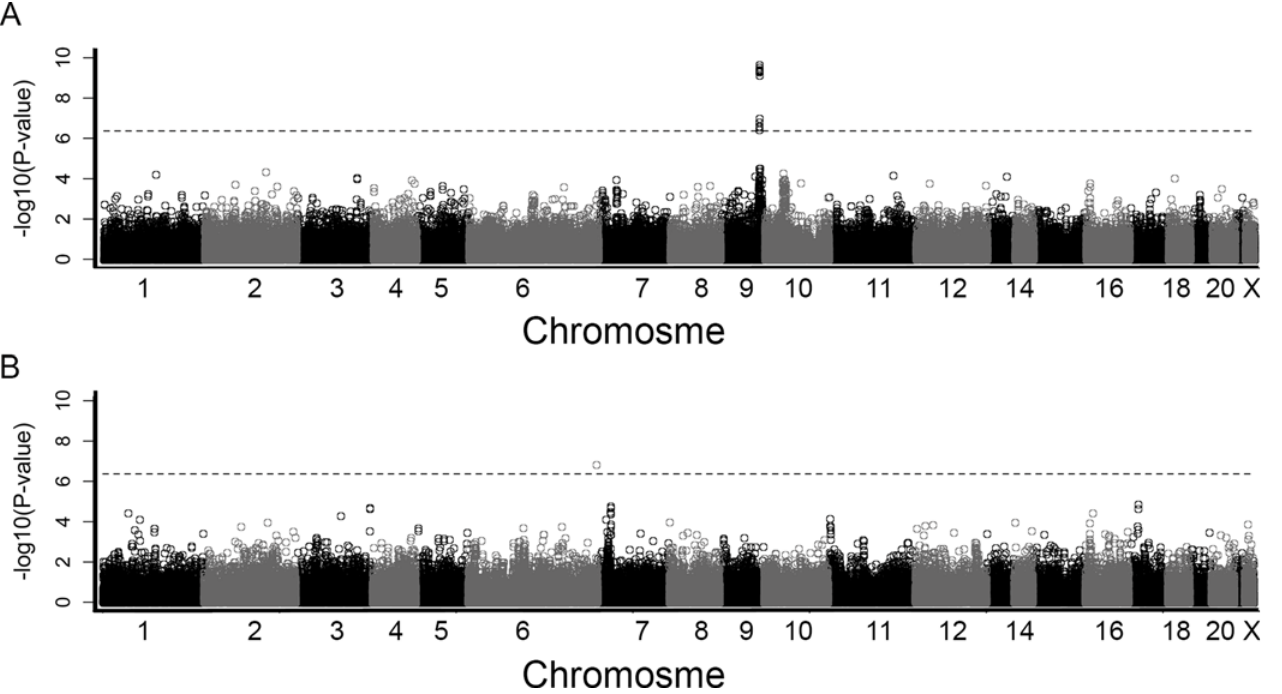
Fig 1. Manhattan plot for the genome-wide association analyses in ACS patients (A) and controls (B). For each SNP, the – log10 (P-value) is plotted against the order on the chromosomes starting with 1 – 22, Y and X, separated by different colors. The dashed line indicates the threshold for statistical significance (Bonferroni adjusted P =